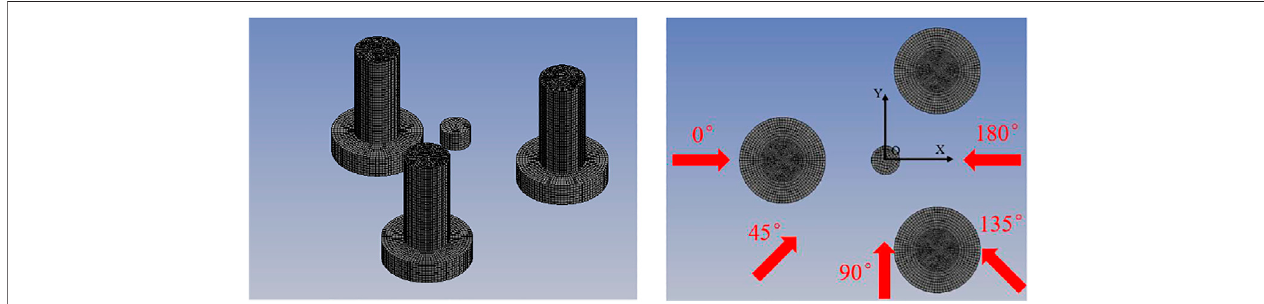
FIGURE 2 | The hydrodynamic model for the FWWP.